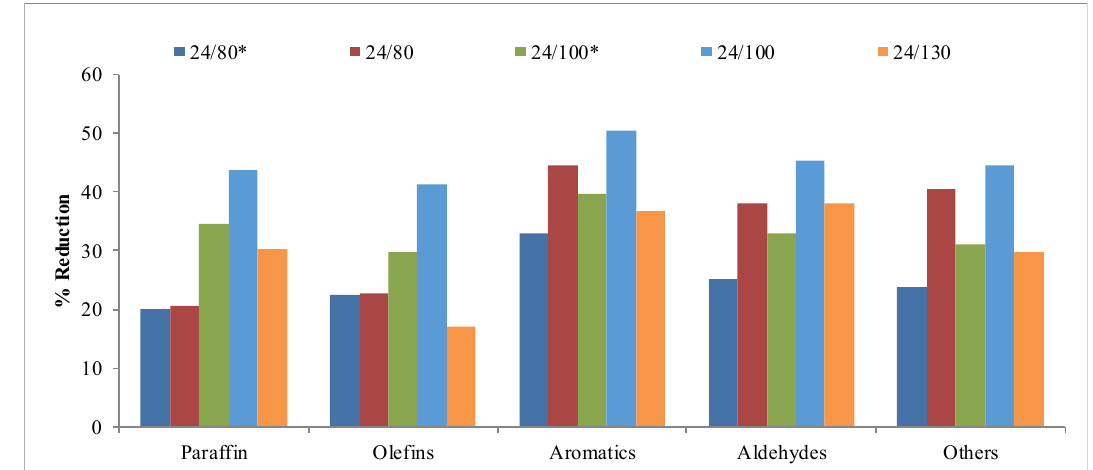
Figure 9. Reduction obtained for the different families of compounds in the gases collected in the study of the hydrothermal treatment temperature. * Synthesis developed without reducing the supernatant liquor before the hydrothermal treatment.